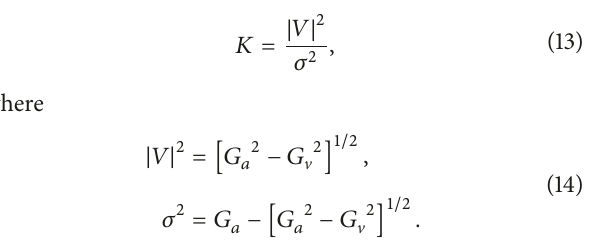
and it was located at minimum distance of 2 m away